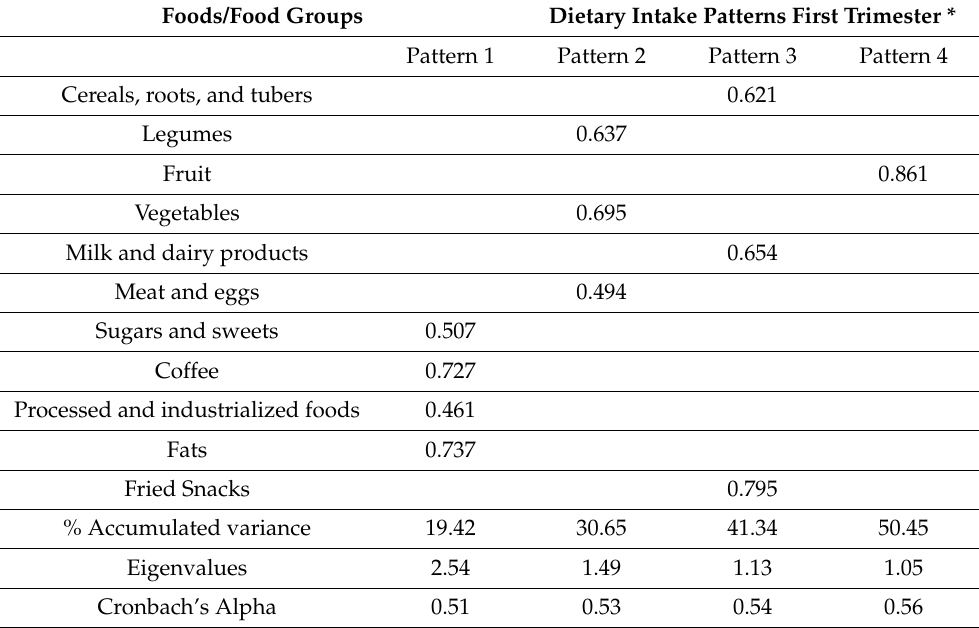
Figure 2. Cattel Graphic Test (scree plot) for dietary patterns identified in the first and third trimesters of pregnancy. Santo Antônio de Jesus, Bahia, 2012–2013. Table 2. Distribution of factor loads for the four components (dietary patterns) identified in the first and third trimesters. Santo Ant ô nio de Jesus, Bahia, Brazil